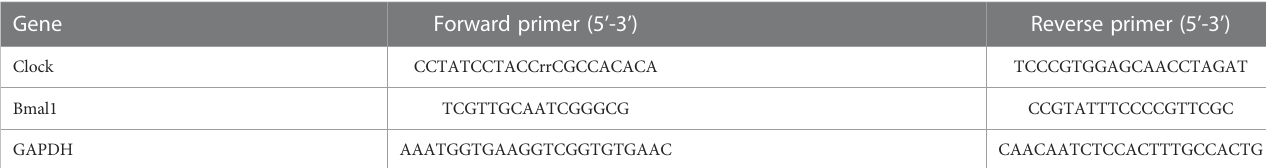
TABLE 1 Primer sequences for QRT-PCR